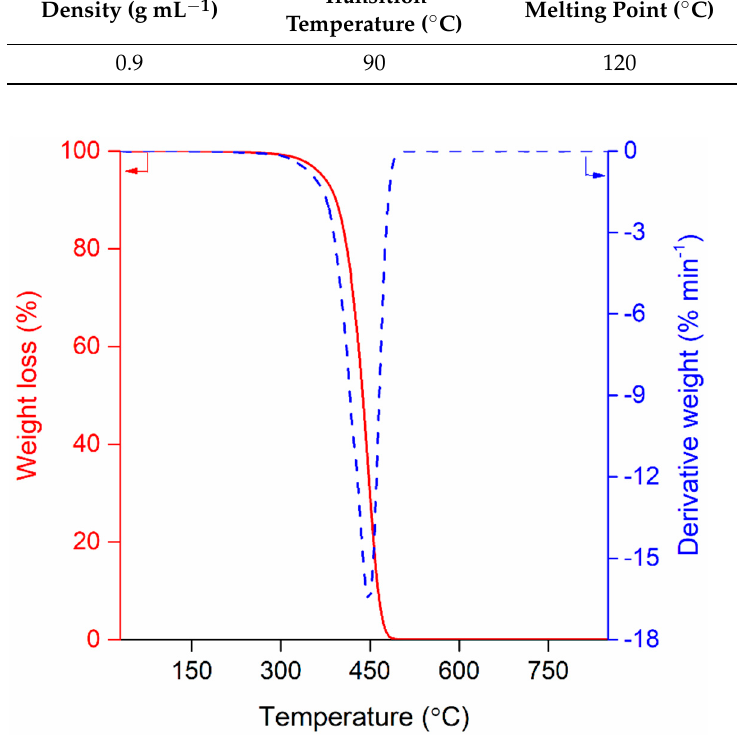
Figure 1. Thermogravimetric analysis (TGA) and derivative weight profiles of the low-density polyethylene (LDPE) sample used as the feedstock in this study. Table 1. Properties of the LDPE sample used as the feedstock in this study.